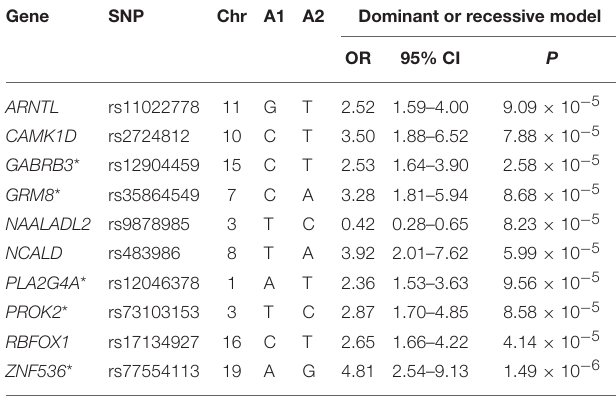
TABLE 2 | Odds ratio analysis with odds ratios after adjustment for covariates between treatment response and the top 10 SNPs.